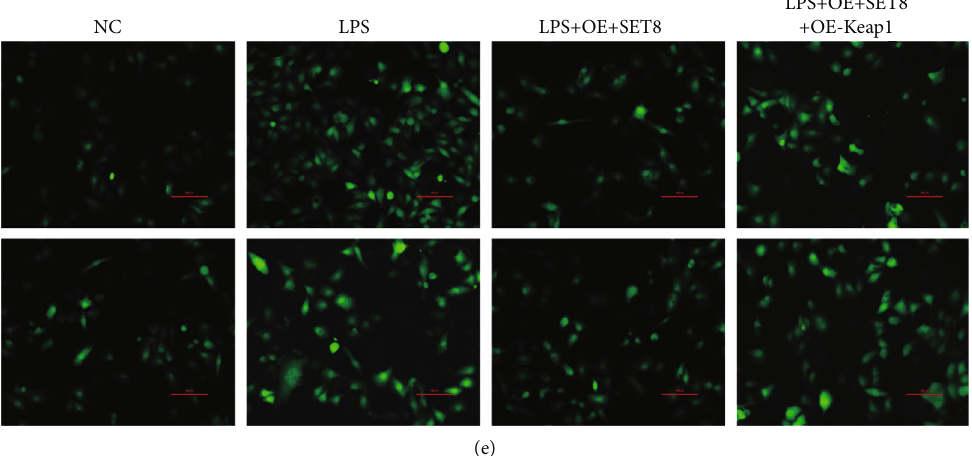
Figure 4: SET8 inhibits oxidative stress-induced autophagy and glial scar formation in astrocytes via the KEAP1-Nrf2-ARE signaling pathway. (a) Western blotting analysis of the signaling pathway-related proteins Keap1 and Nrf2; (b) the astrocyte signature proteins GFAP and Vimentin; (c) the astrocyte autophagy-related proteins LC3II/I, P62, and Beclin1; (d) the glial scar formation-related proteins brevican and neurocan in the NC+ LPS, NC+LPS+OE-SET8, and NC+LPS+OE-SET8+OE-Keap1 groups under di ff erent conditions; (e) DHE staining was performed to detect ROS levels in the NC+LPS, NC+LPS+OE-SET8, and NC+LPS+OE-SET8+OE-Keap1 groups under di ff erent